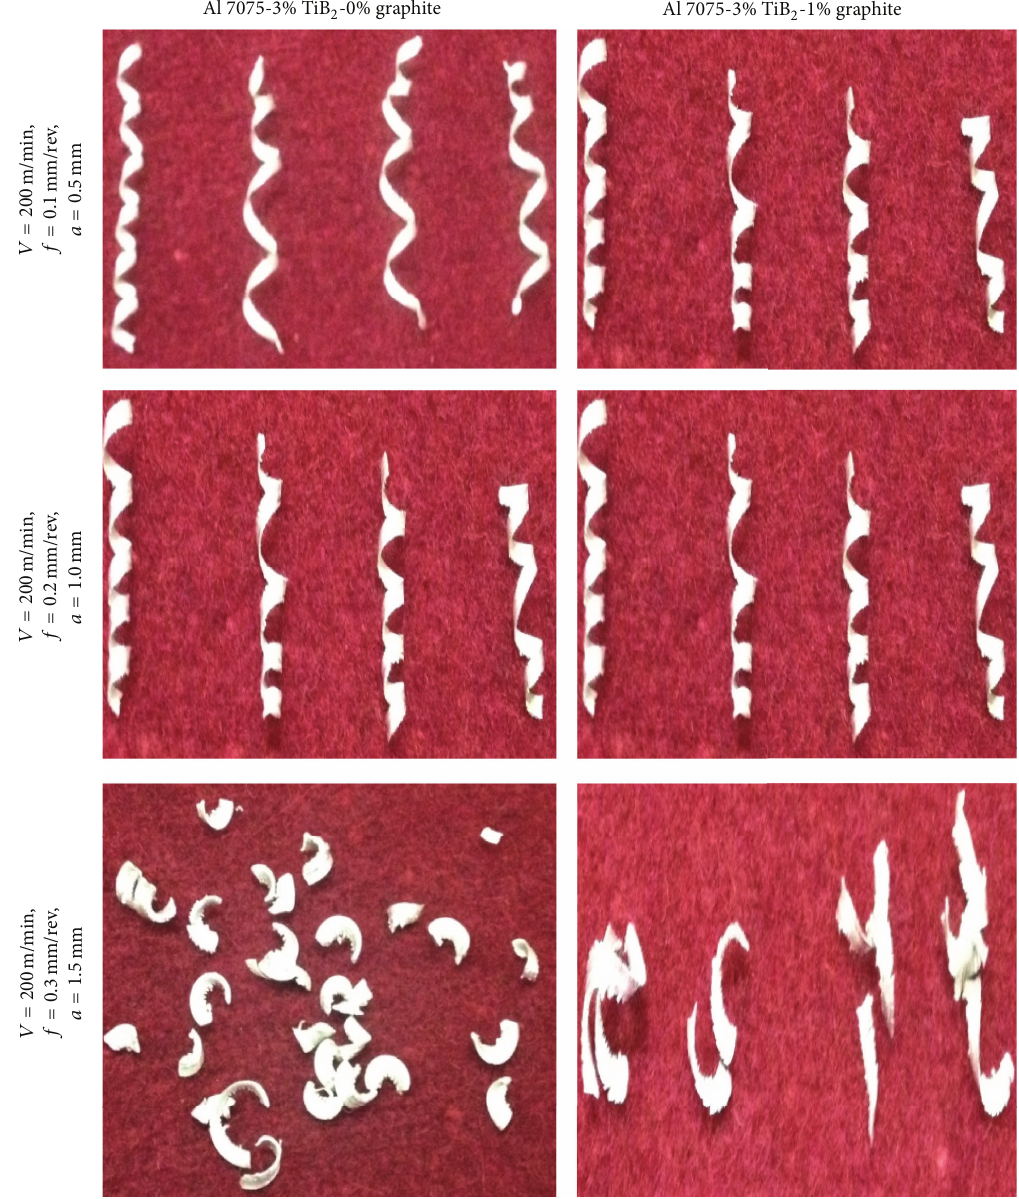
Figure 11: Examination of chip morphology with selected cutting parameters of AA 7075-3% TiB 2 -0% Gr and AA 7075-3% TiB 2 -1% Gr hybrid in situ composite with the cutting tool of 0.8 nose radius